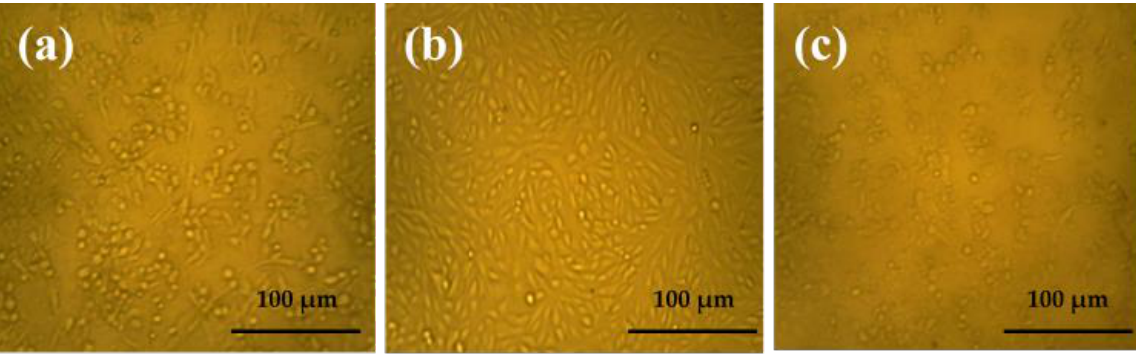
Figure 8. The microscopic images of viable cells of CS films at Yb 2 O 3 /V 2 O 5 /GO@CS, ( a ) the cells with a film concentration of 20 mg/mL, ( b ) at a concentration of 5 mg/mL, ( c ) at a concentration of 2 m/mL (scale bar = 100 µm).